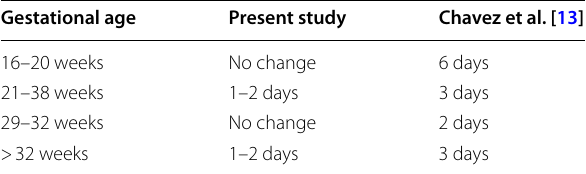
Table 5 Scatter diagram showing correlation between GA and TCD